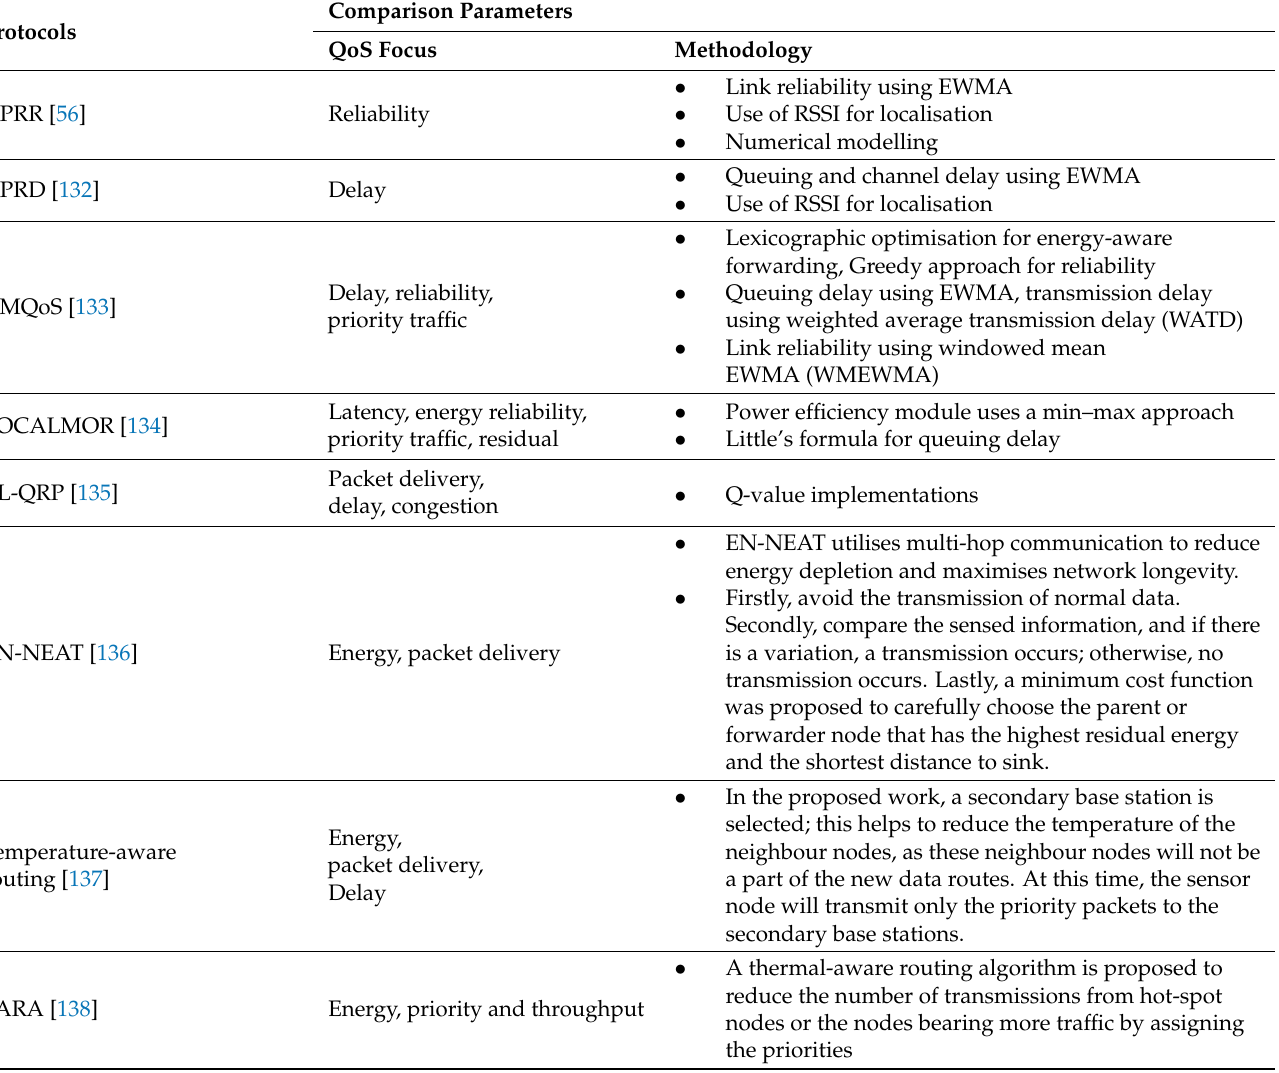
Table 9. Comparative analysis of QoS-based